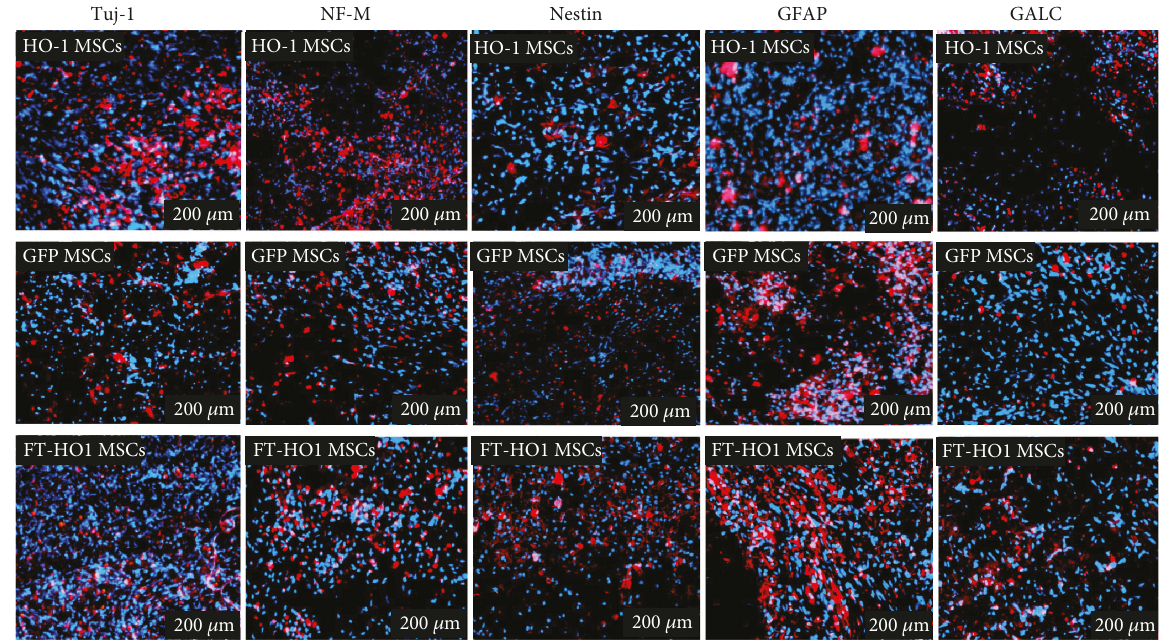
Figure 6: Immuno fl uorescent staining for the expression of neural (Tuj-1, NF-M, and nestin) and glial (GFAP, GALC) cells. Sections were stained with Tuj-1, NF-M, nestin, GFAP, and GALC in red, and nuclei were stained with DAPI in blue. Each image represents 4 samples per group with a scale bar of 200 μ m.